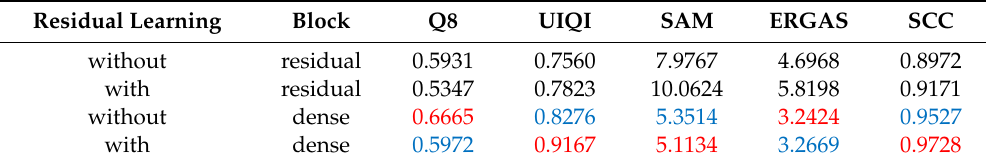
Table 12. Quantitative evaluation results of di ff erent architectures on the WorldView-2 dataset. The best and the second best results are in red and blue,